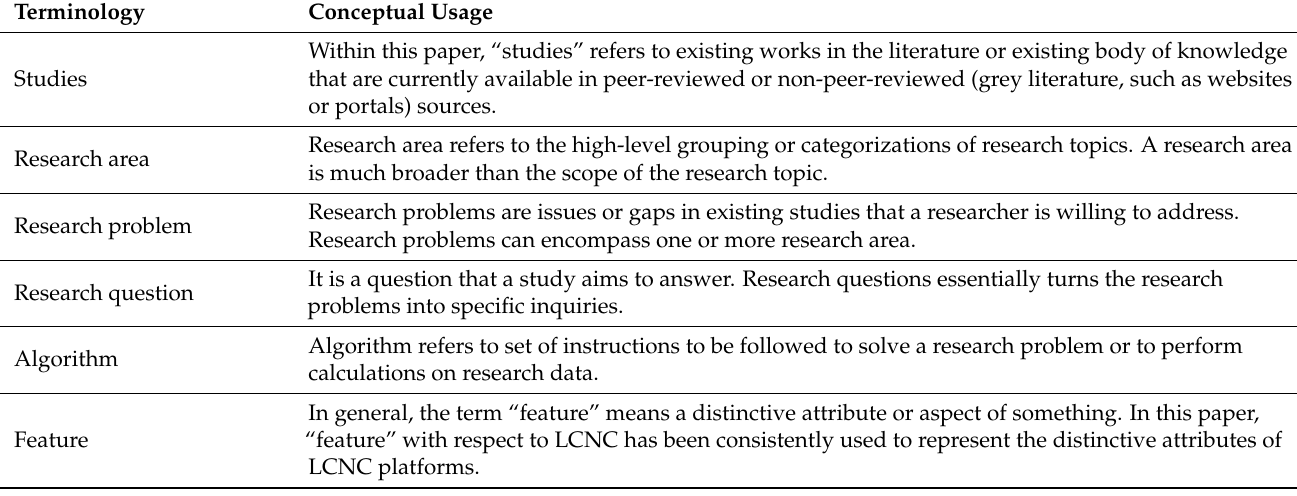
Table 1. Consistent use of common